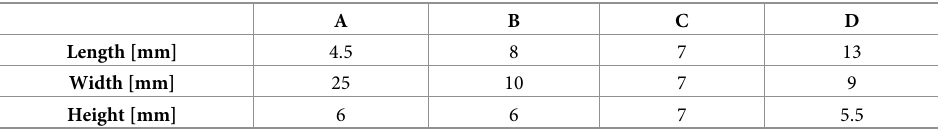
Table 6. Dimensions for the creation of tip volumes for all catheters.